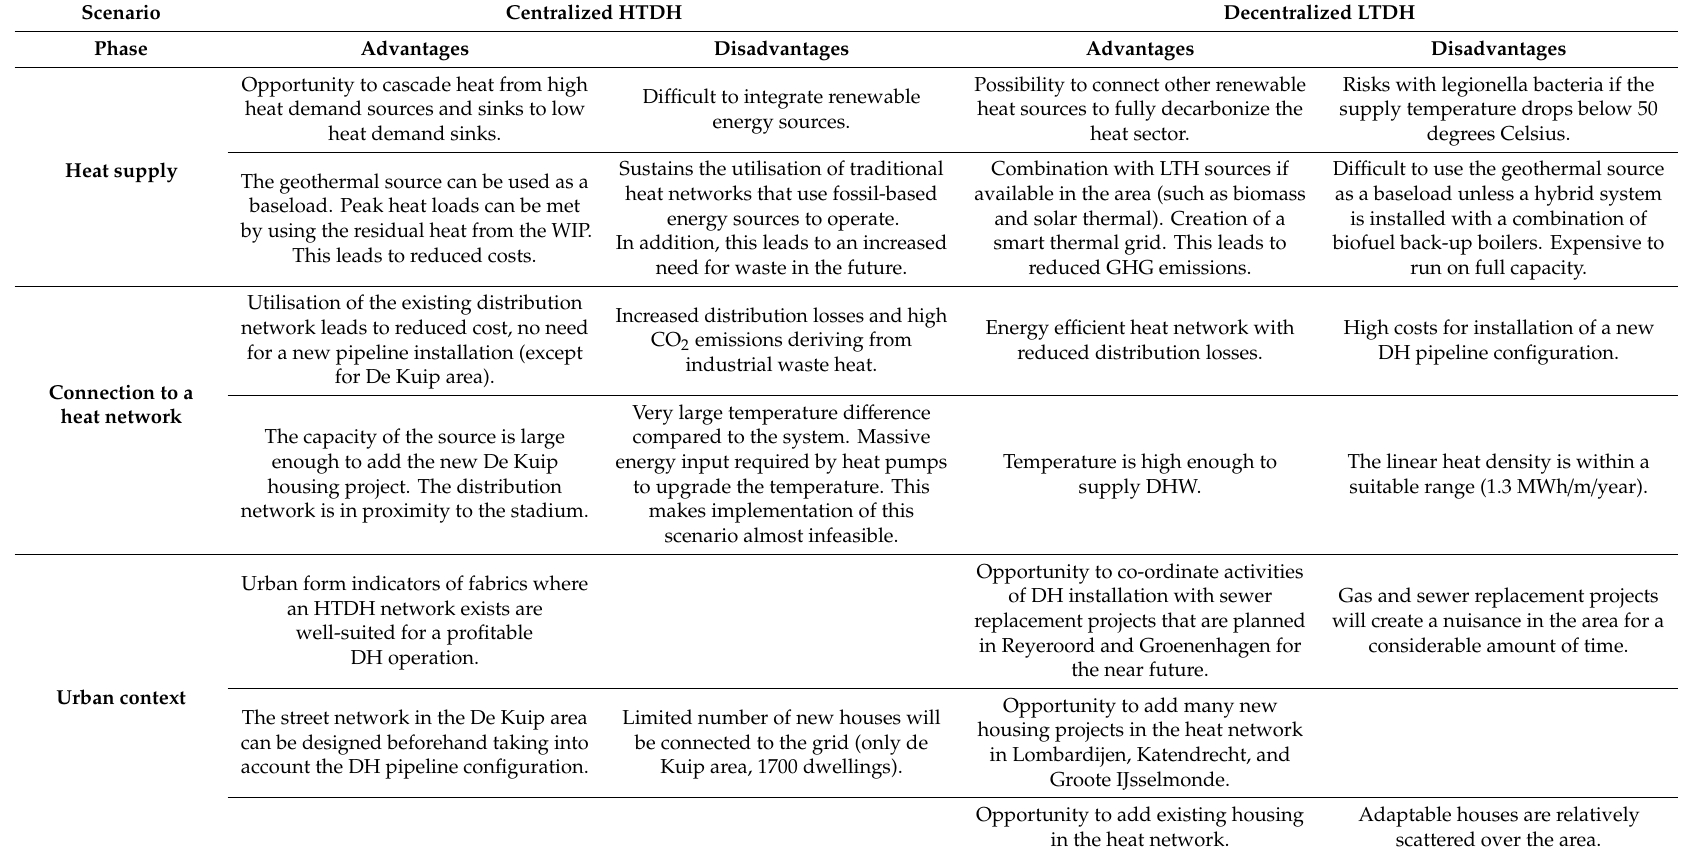
Table 2. Advantages and disadvantages of the two proposed